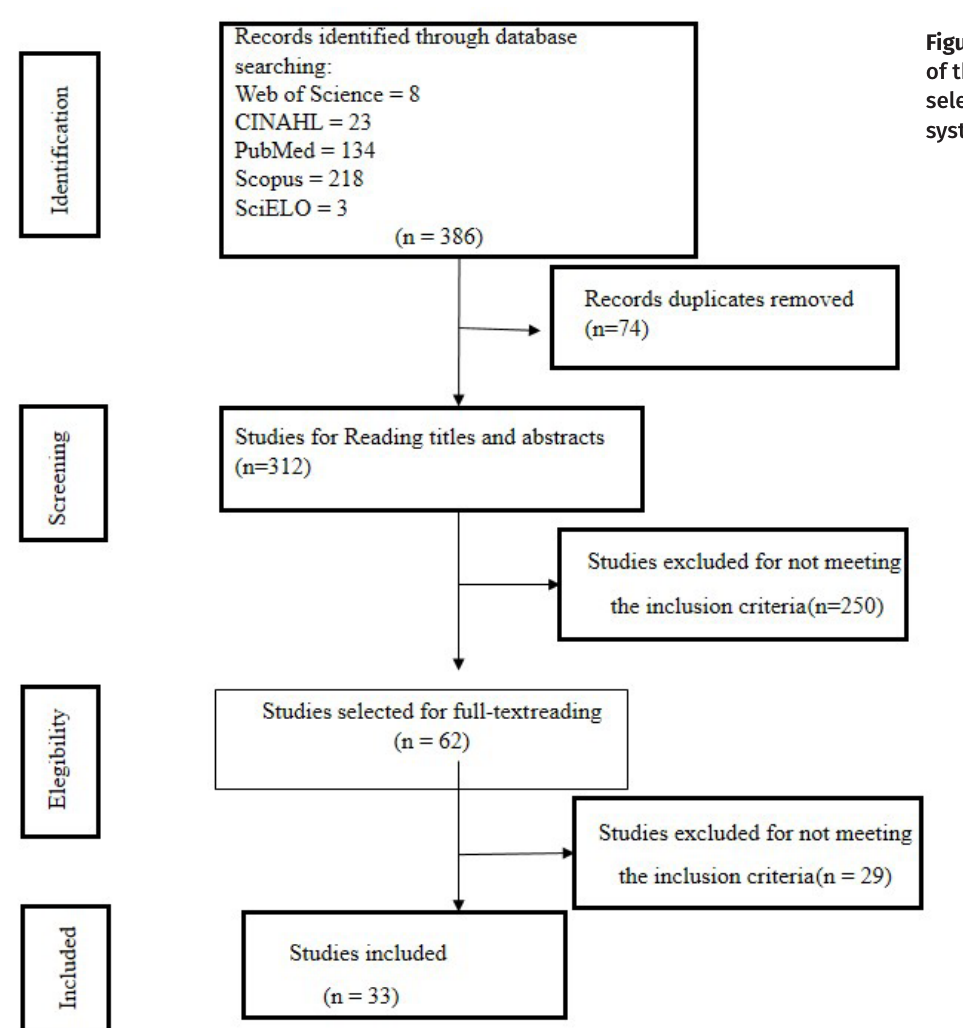
Figure 1. Flowchart of the search and selection of studies for systematic